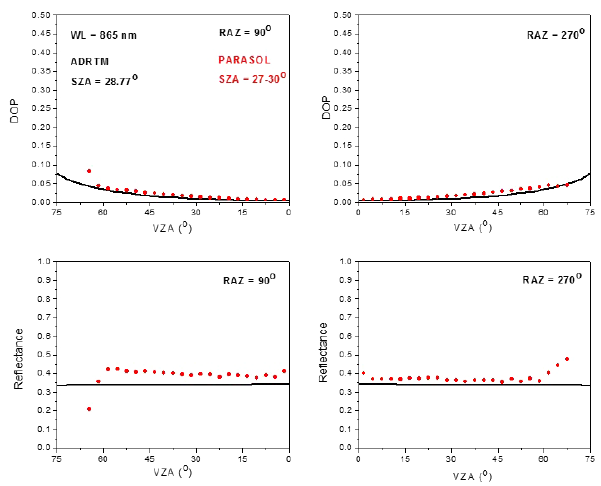
Figure 15. Same as in Fig. 14 but at RAZs of 90 and 270 ◦